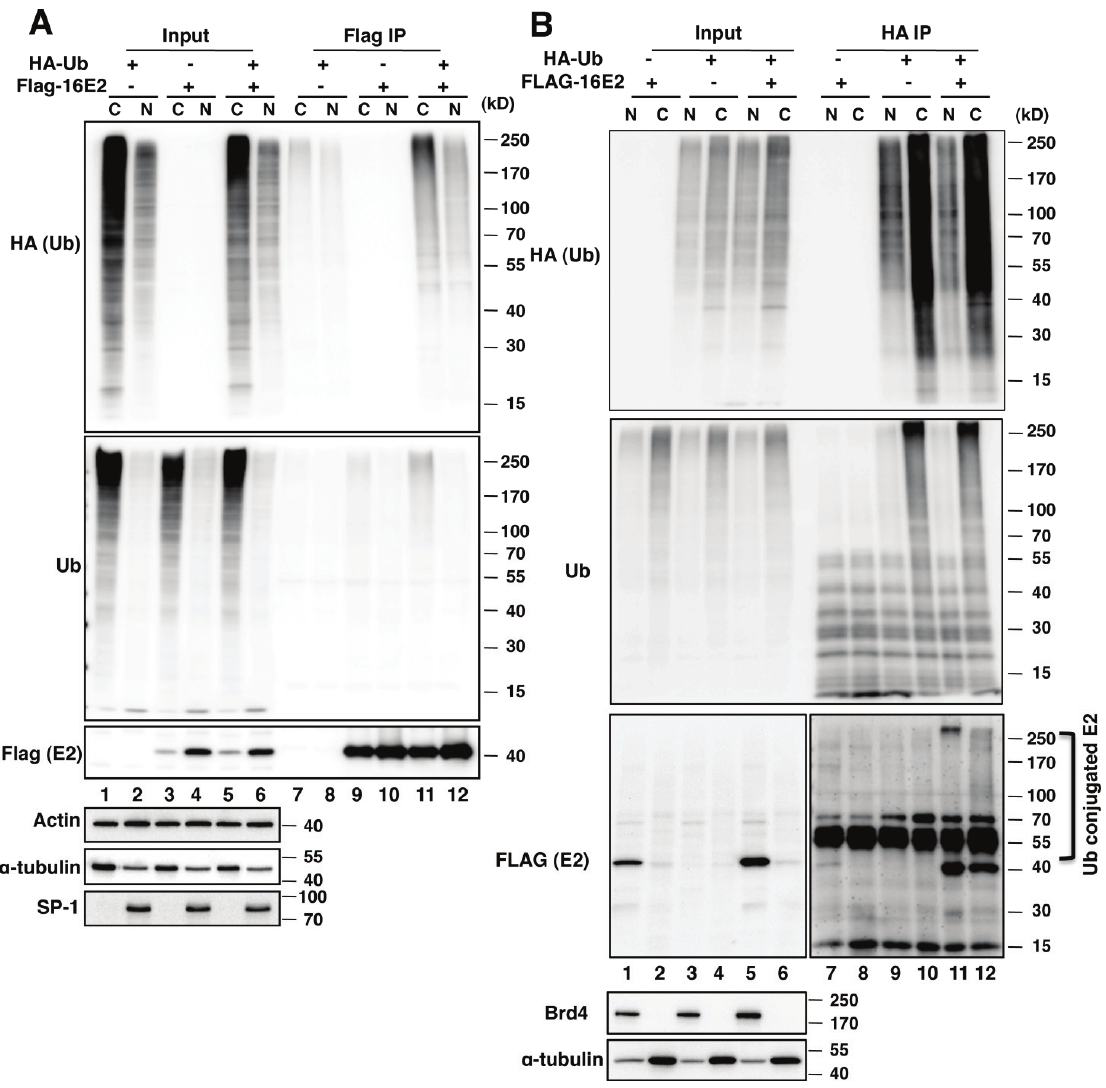
Figure 1. E2 is predominantly ubiquitylated in the host cytoplasm. HEK293T cells were transfected with plasmids encoding HA-tagged ubiquitin, FLAG-tagged HPV16 E2 or both as indicated. Forty-four hours post-transfection, the cells were treated with 30 µM MG132 for 4 h, and then lysed to obtain cytoplasmic extracts and nuclear extracts. ( A ) FLAG immunoprecipitation was performed to isolate ubiquitylated HPV16 E2 from both cytoplasmic extracts (C) and nuclear extracts (N); ( B ) HA immunoprecipitation was performed to isolate HA-ubiquitin conjugated proteins. The purified immune complexes were resolved on a sodium dodecyl sulfate-Polyacrylamide gel electrophoresis (SDS-PAGE) gel. Western blotting was performed using antibodies recognizing HA (for HA-tagged ubiquitin), Ub (for total ubiquitin), FLAG (for E2), actin, tubulin, Brd4 and SP-1. Tubulin was used as a cytoplasmic protein marker. Brd4 and SP-1 serve as nuclear